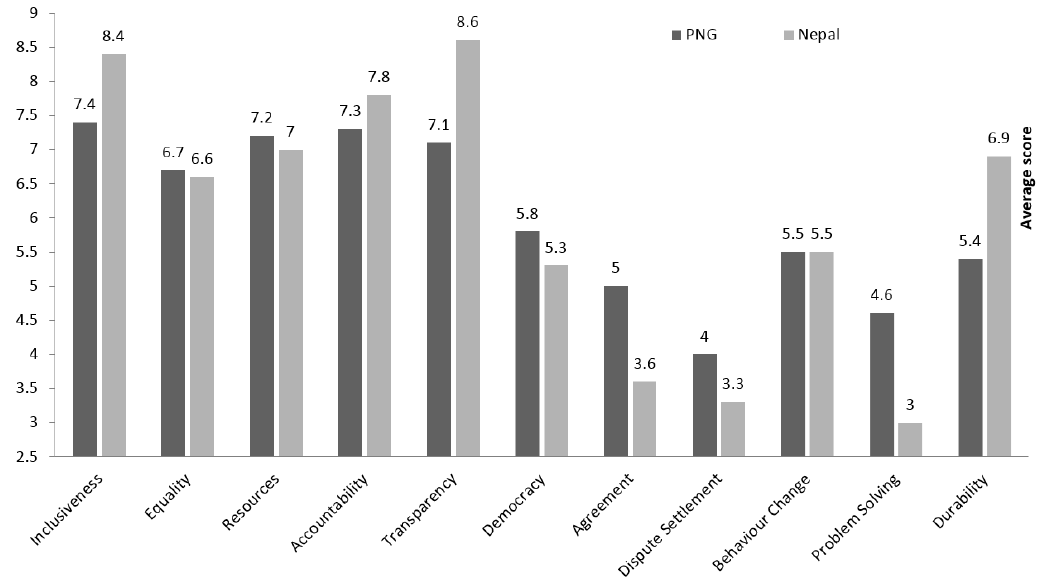
Figure 2. Prioritisation at the indicator level of 11 different governance values in Nepal and PNG.